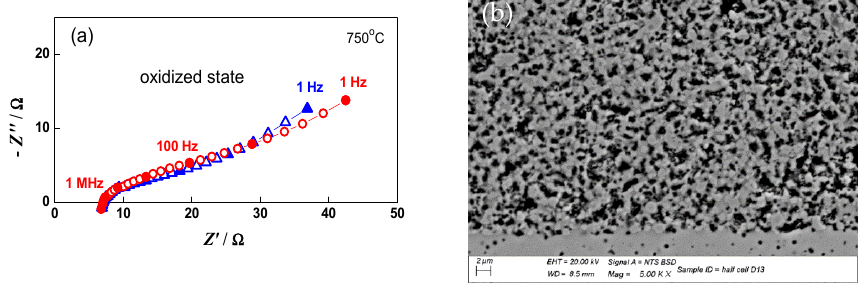
Figure 8. Redox cycling of anode/electrolyte sample: ( a ) impedance diagrams in oxidized state after the 4th ( ∆ ) and 8th ( ○ ) oxidation; ( b ) SEM image of the interface anode/electrolyte after 15 redox cycles.